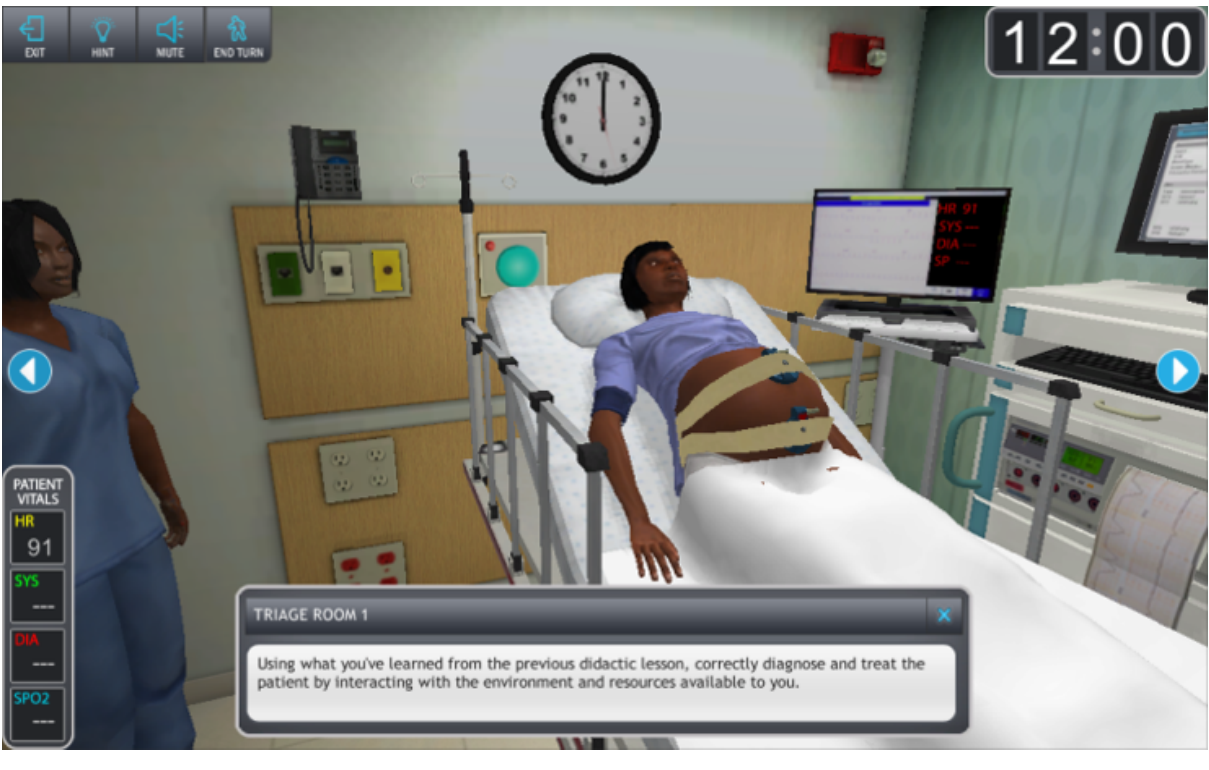
Figure 3. Depiction of the avatar participants utilized to navigate the serious